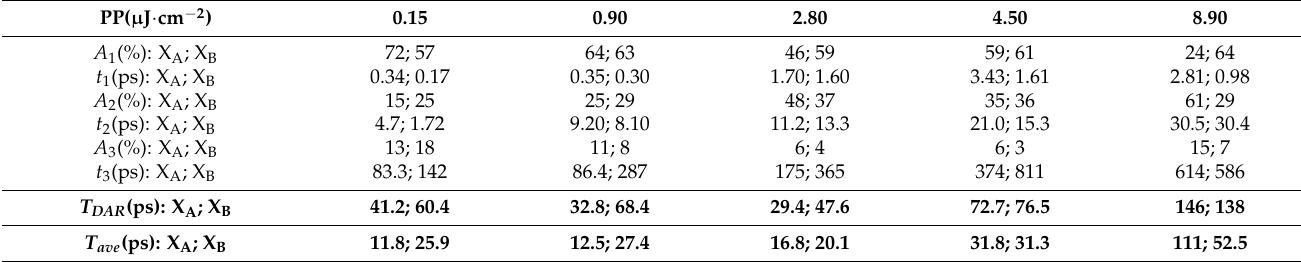
Table 2. List of the fit parameters for the depletion recovery signal of excitons X A and X B , upon excitation of the 2D-WSe 2 monolayer at ~3.1 eV with different densities. A i and t i are the amplitudes and time constants of the exponential component i . The amplitude-weighted average depletion recovery times T ave are calculated as ∑ i A i t i , and T DAR are calculated as + A + A ( A ) / ( A ) 2 t 2 3 t 3 2 3